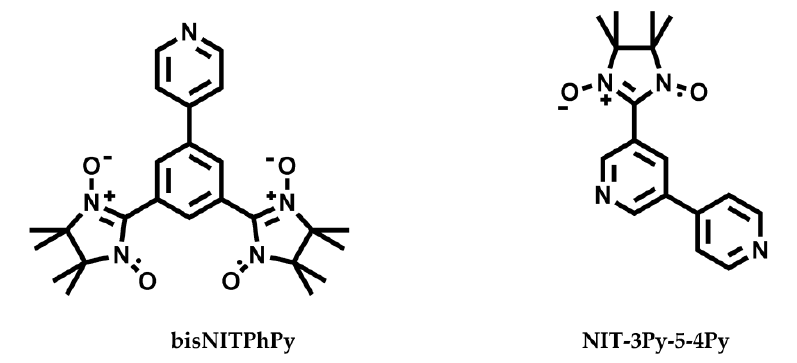
Table 1. Crystallographic structural data of two-dimensional polymers 1 and 2 .